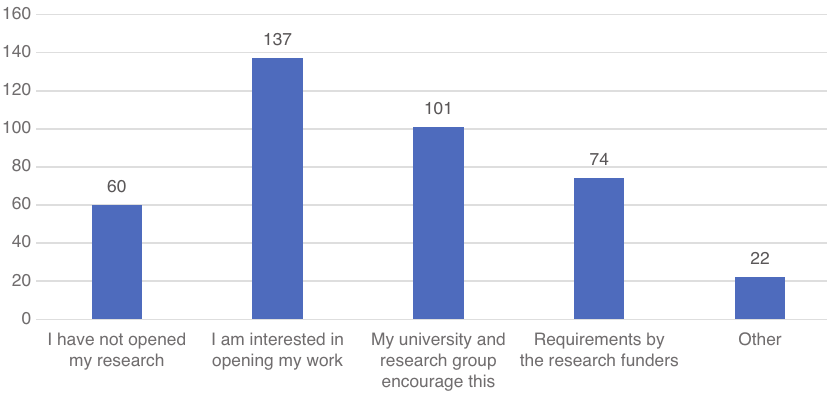
Fig. 7: What motivates the respondents (N=261